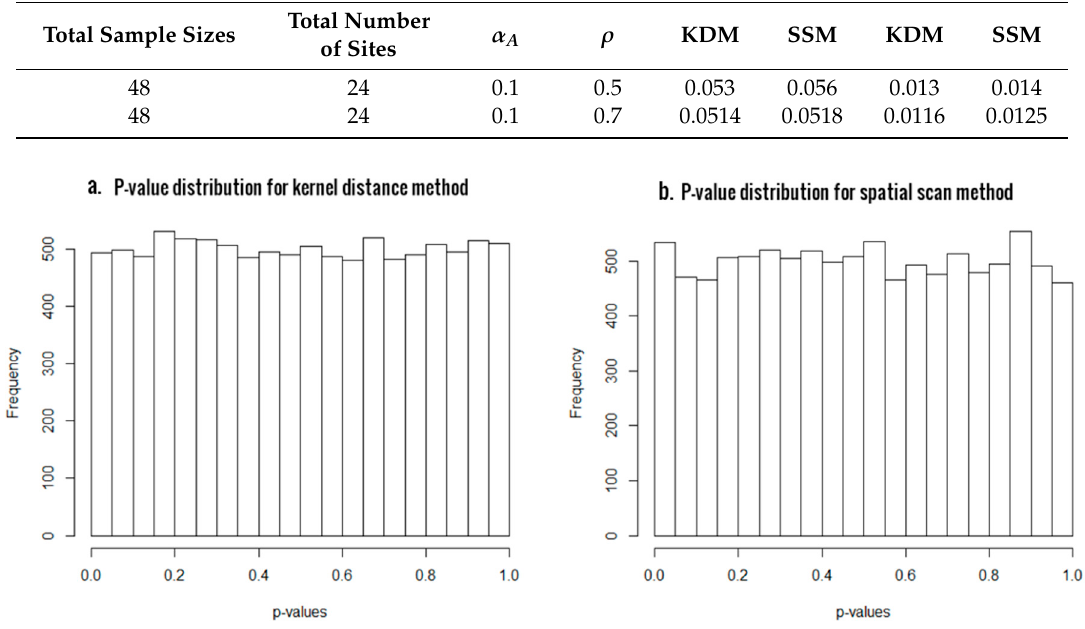
Figure 1. Histogram of p -values from scan statistic method (SSM) (panel a ) and kernel distance statistic (KDM) (panel b ) for sample size of 48, with 24 CpG sites.